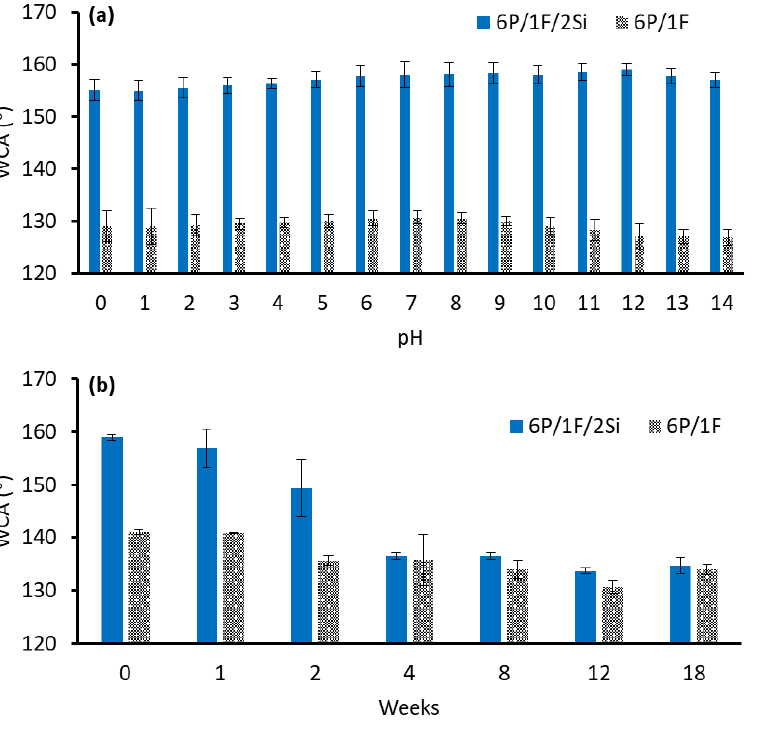
Figure 8. Results for 6P/1F/2Si and 6P/1F surfaces are shown as follows. ( a ) WCA vs the pH of water drops. ( b ) WCA for samples which were exposed to artificially accelerated UV radiation for various periods (weeks).